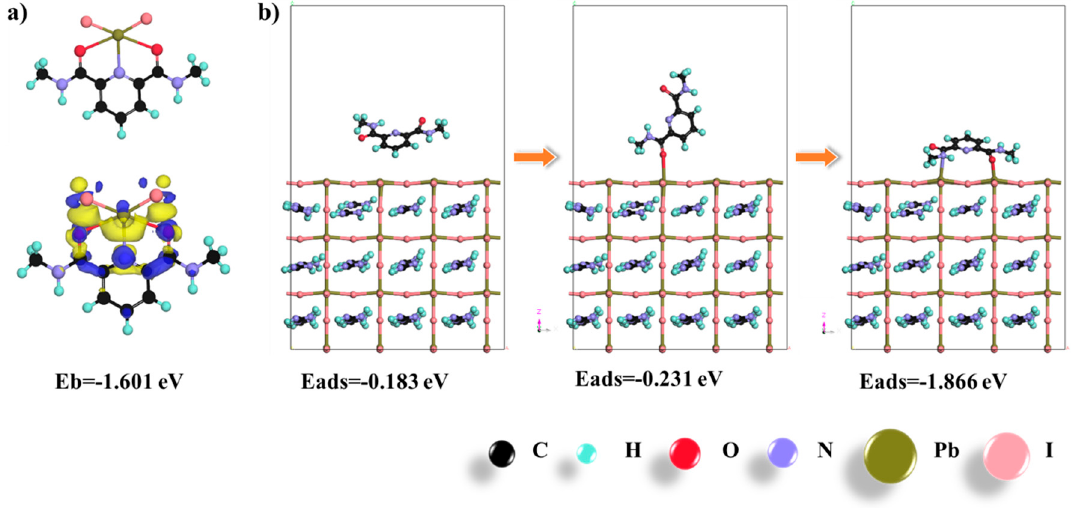
Figure 3. Theoretical models of chelation interactions between perovskites and pyridine units. ( a ) Absorption energy between PAT molecule and FAPbI 3 . ( b ) Different coordination states between PAT molecule and FAPbI 3 .